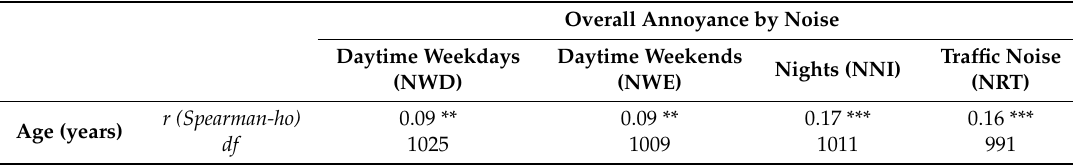
Table 6. Non-parametric correlations between age and reported annoyance by noise.